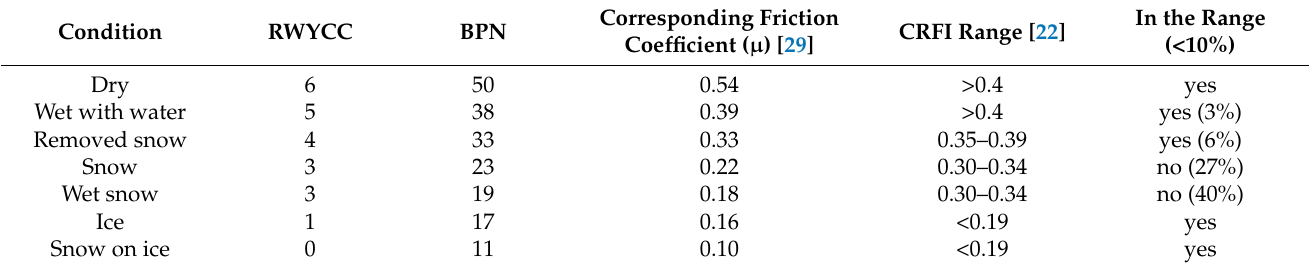
Table 3. Comparison between the CRFI values of friction coefficient ( µ ) and